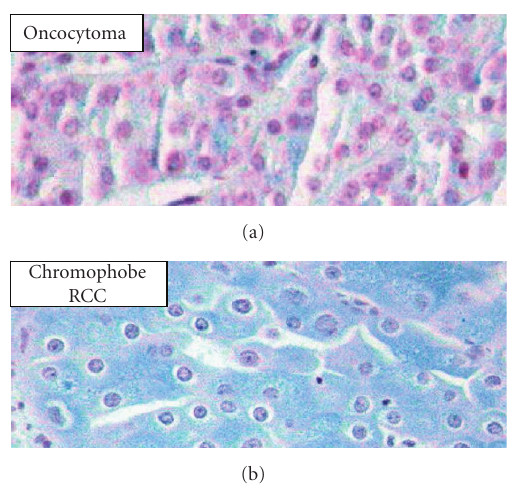
Figure 4: Colloidal iron to distinguish oncocytoma (negative) and chromophobe renal cell carcinoma (positive).